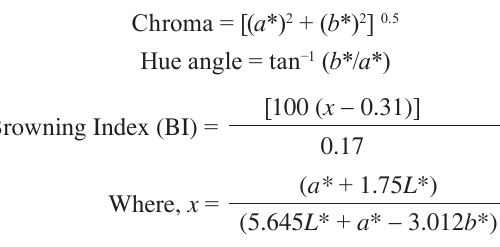
Table 1 Chemical composition of yellow corn genotypes (% on dry weight basis) Genotype